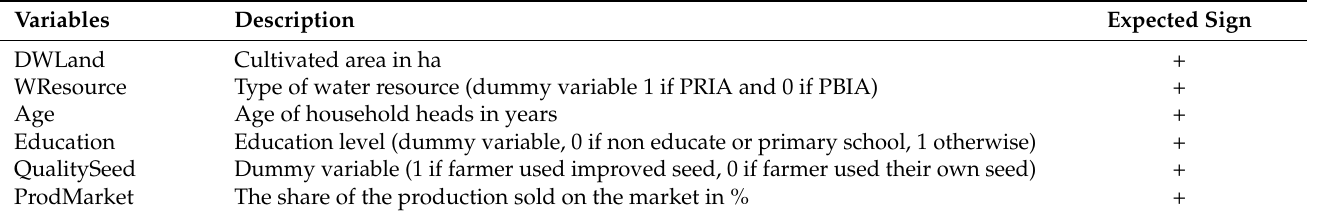
Table 1. Definition of explanatory